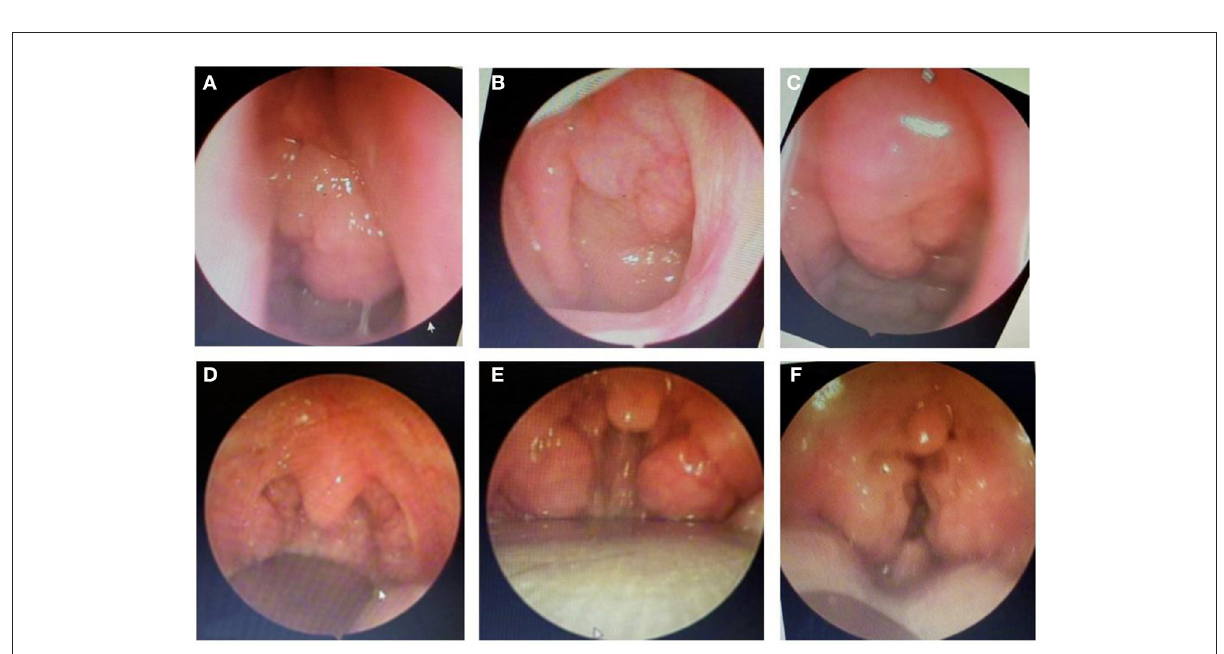
FIGURE4 Endoscopic images of adenoid hypertrophy (A–C) and tonsillar hypertrophy (D–F) .